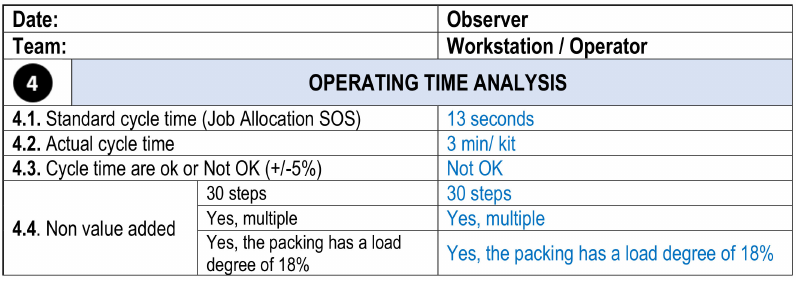
Figure 18. Duration analysis questionnaire of the production system “plastic injection”.